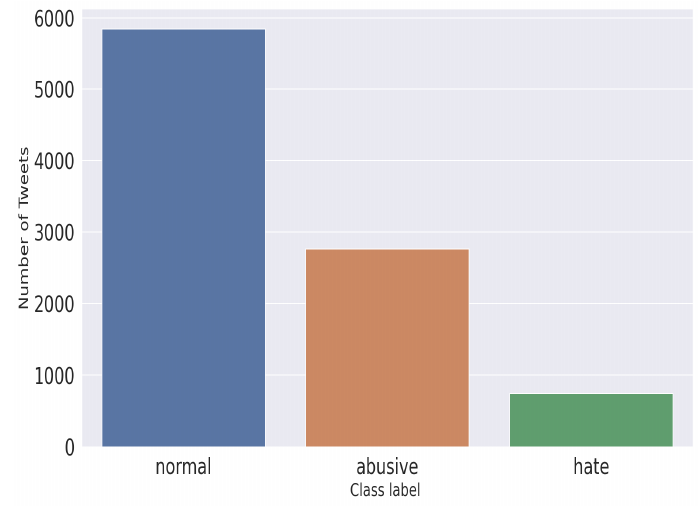
Figure 4. Tweets in each